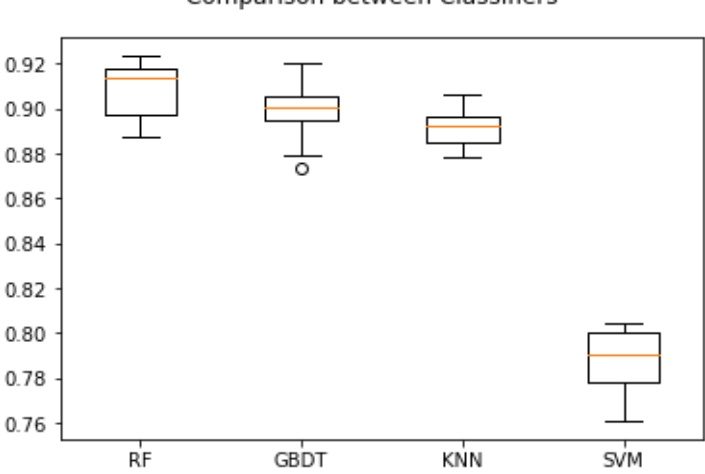
Figure 5. Box plots corresponding to the accuracy of the classification of the two classes of seizure and seizure-free. The orange line in the boxes marks the median. The final accuracy score is deter- mined by averaging the 10 ROC curves and calculating the AUC of the mean